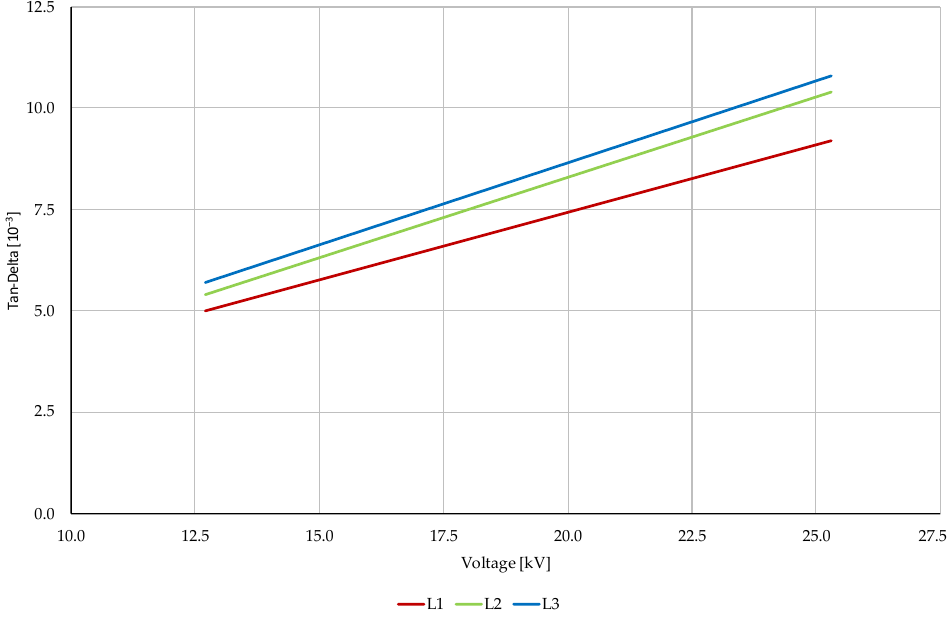
Figure 2. Measurement of tan δ using a measuring car.